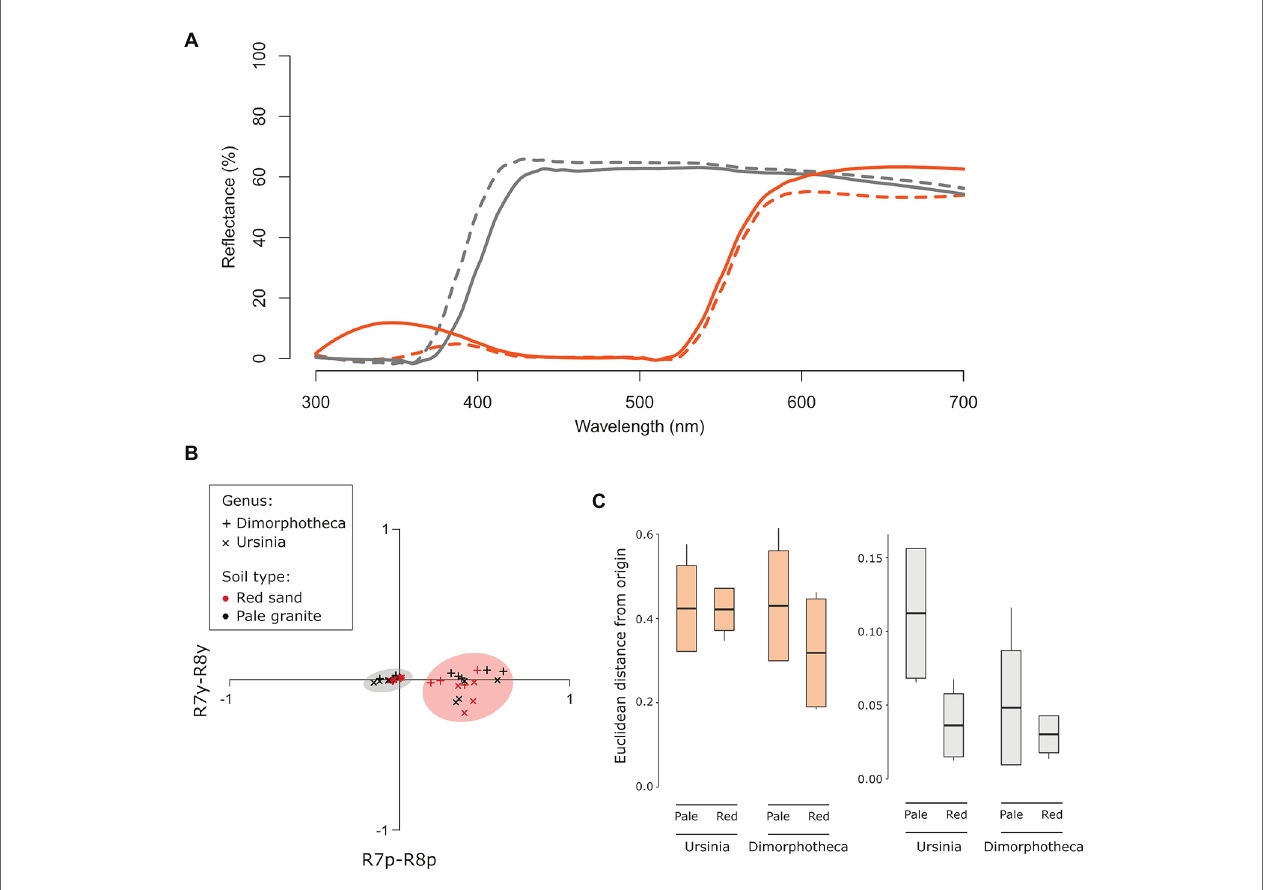
FIGURE 4 | Distinguishability and detectability of daisy flower color in fly vision. Orange flowers are indicated in orange and white flowers in gray throughout. (A) Reflectance spectra of ray florets of the four focal daisy species. Dotted lines indicate Dimorphotheca species, and solid lines show Ursinia species. (B) Flower colors modeled in the Troje (1993) fly color space using Eristalis receptor sensitivities with adaptation against the alternate soil backgrounds. The orange and gray circles indicate orange and white-flowered species, respectively. (C) Difference in detectability, quantified as Euclidean distances from the origin of fly color space, of the orange ( Dimorphotheca sinuata , Ursinia cakilefolia ) and white ( Dimorphotheca pluvialis , Ursinia speciosa ) species on the two soil backgrounds (pale and red soils). Species did not contrast significantly more strongly against their native soils (pale for orange flowers, red for white flowers) than foreign